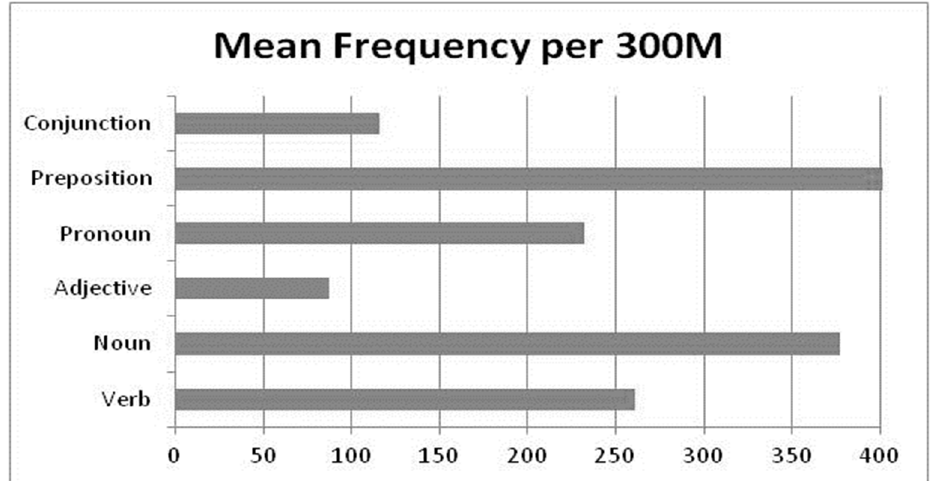
Figure 1. Lexical frequency (means) of deleted words (per 300 million), based on Lyashevskaya and Sharov (2009). X-axis: count; Y-axis: part of